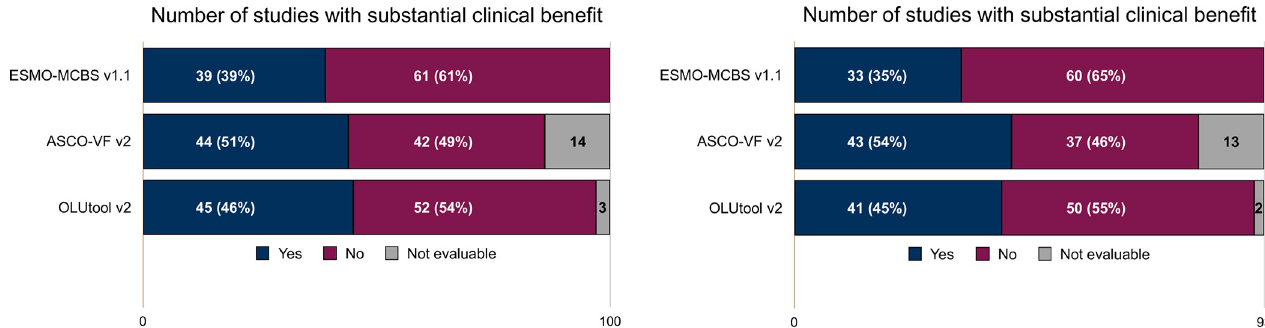
Fig 2. Number of studies which fulfilled the criteria for substantial clinical benefit for the respective frameworks. A. All studies; B: studies in the palliative